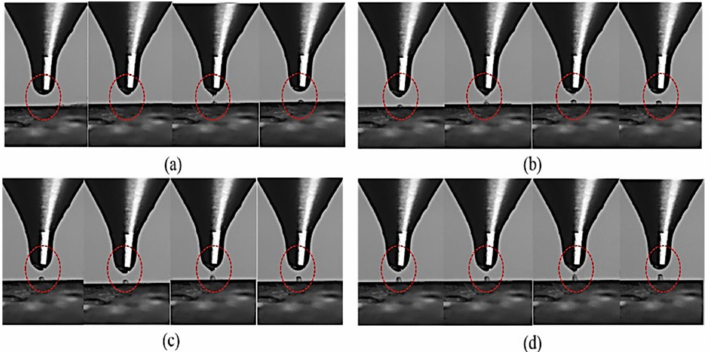
Figure 12. A vertical deposition process of droplets on demand: ( a ) the first droplet deposited;